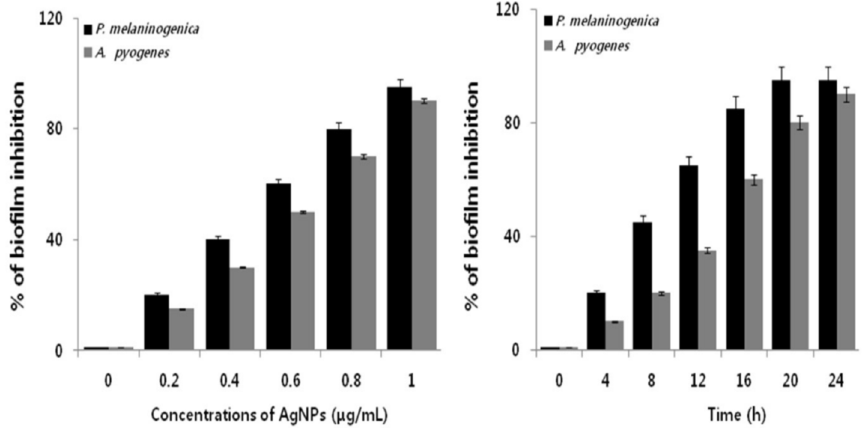
Figure 13. Anti-biofilm behavior of AgNPs on P. melaninogenica and A. pyogenes . ( Left ): Bacterial strains were treated with AgNPs of different concentrations. ( Right ): Bacterial strains were incubated with 0.8 and 1.0 μg/mL of AgNPs, respectively, for 24 h. p < 0.05 was considered statistically